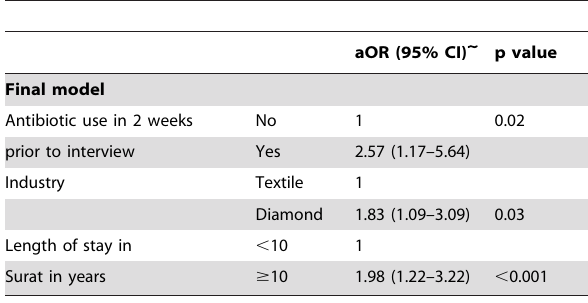
, Adjusted for all variables in the table and age. *STIs: syphilis, herpes simplex virus, gonorrhoea, chlamydia & Trichomonas vaginalis .